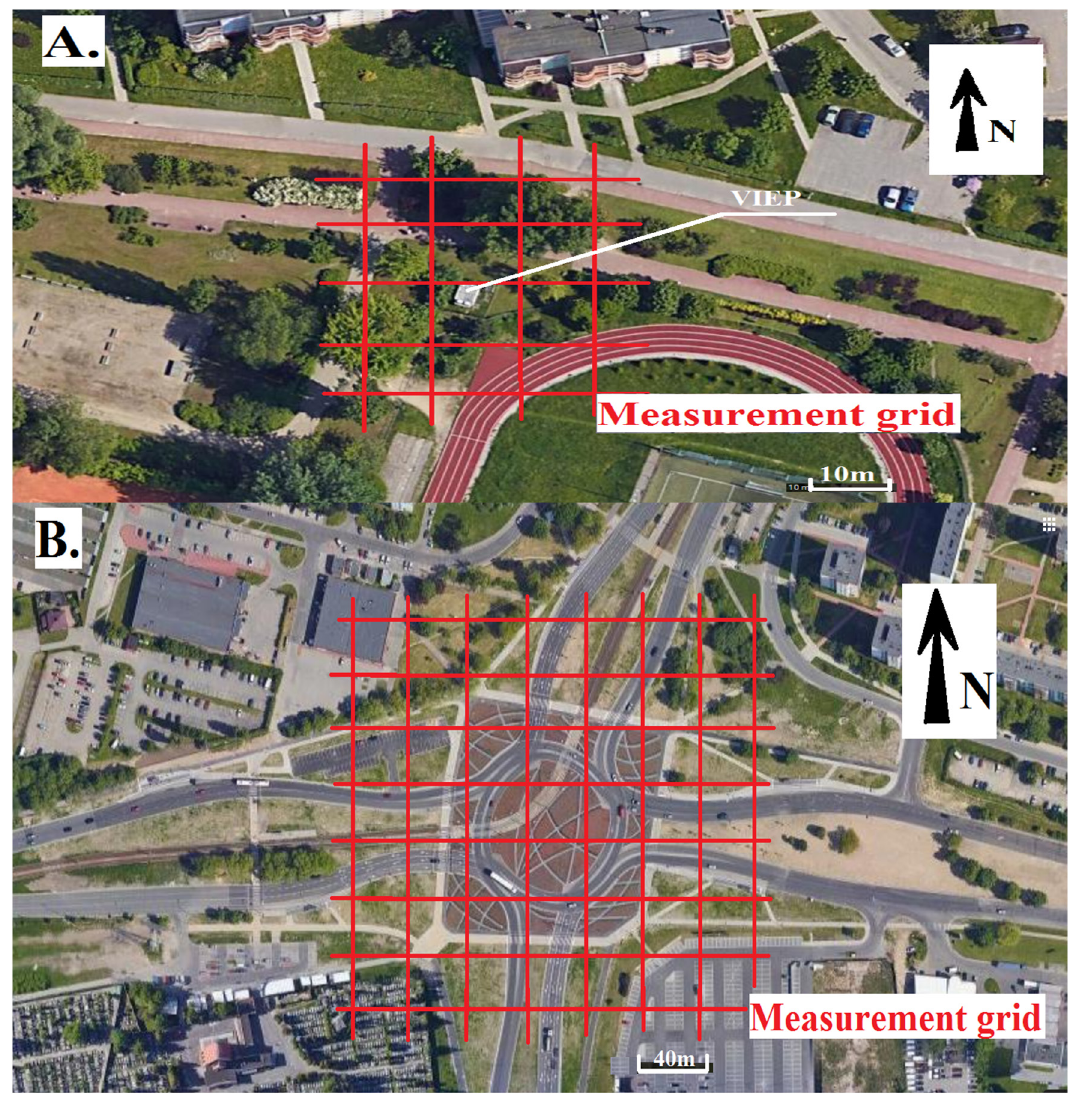
Figure 2. Location of measurement points around the: ( A ). VIEP station; ( B ). crossroads (photo background source: Google Earth Pro).